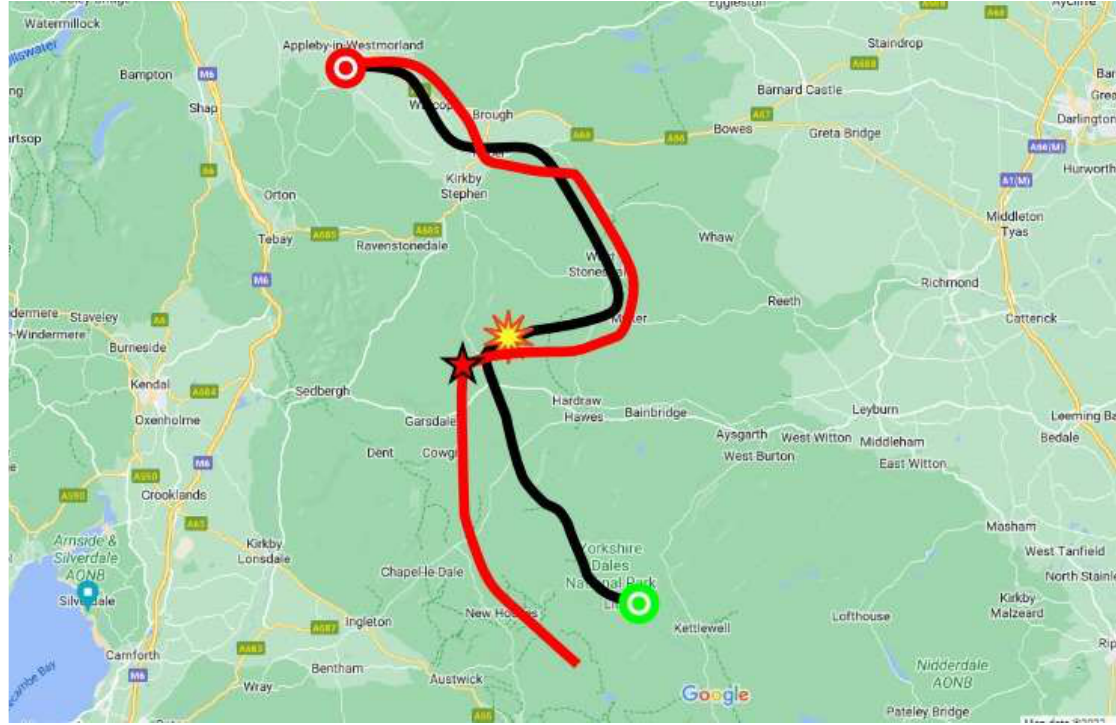
Figure 31. Predicted trajectory (black line) and actual trajectory (red line).